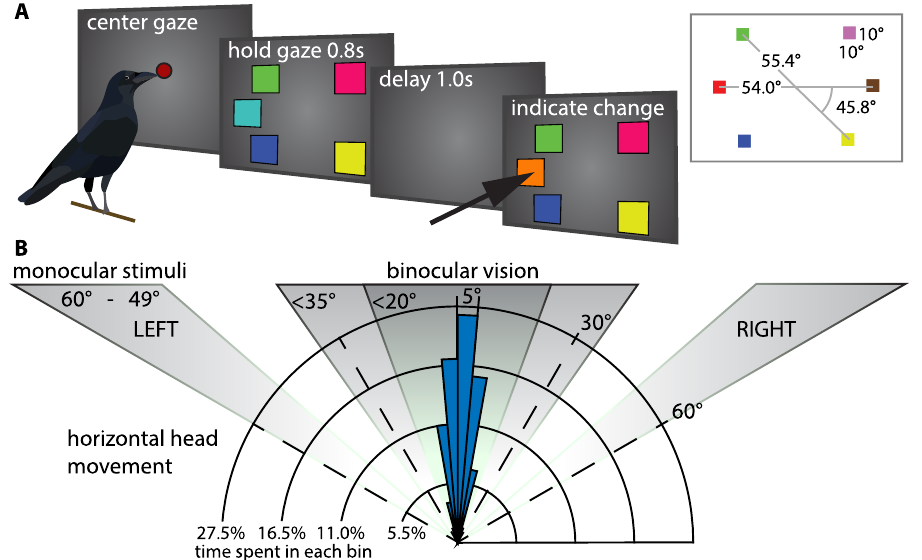
Figure 1. Behavioral protocol and gaze direction. (A) Behavioral protocol. After initiating a trial by placing the head in front of a red dot in the center of the screen, crows were presented with a stimulus-array of colored squares. Following a short memory delay during which the stimuli were not present, the animals viewed the choice array, i.e. the stimulus-array with one color exchanged. A single peck to the changed stimulus (indicated by arrow) resulted in reinforcement. Panel inset illustrates stimulus-placement and dimensions on screen (unit: degree visual angle). (B) Gaze direction and stimulus arrangement. Blue histogram indicates horizontal head- rotation (time spent in bins of 5 degree visual angle) of both animals during the entire experiment. Central grey field indicates binocular visual field of crows, light shading takes head-rotation into account. Lateral grey regions (left and right) indicate area of stimulus presentation on the monitor indicating that stimuli were only viewed with either the left or the right